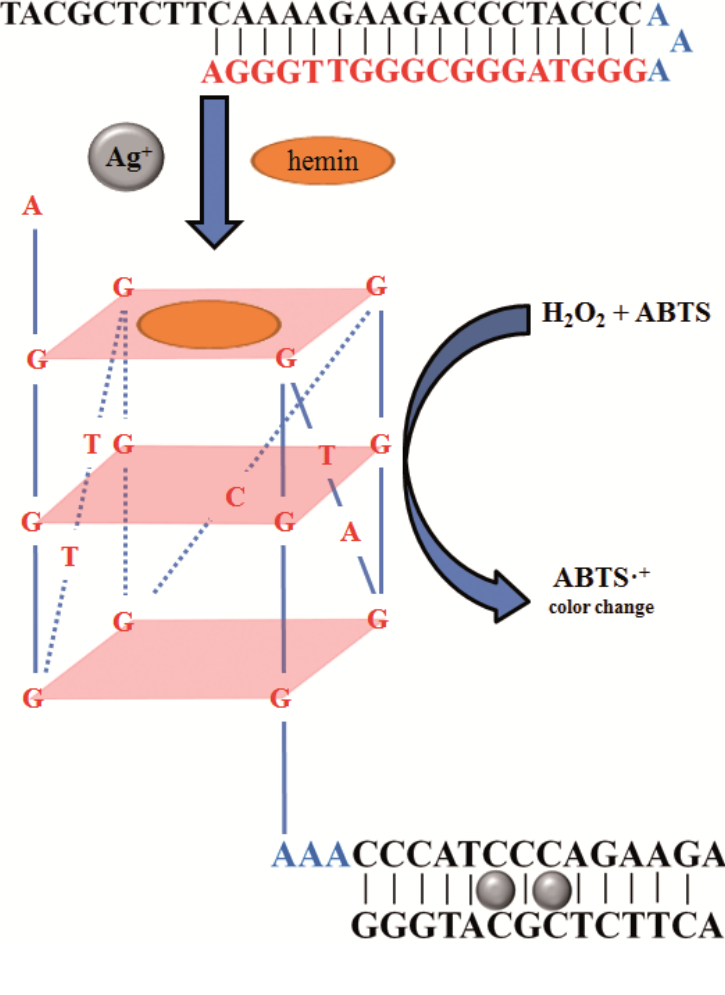
Figure 2. Schematic representation of the G-quadruplex–hemin DNAzyme amplified Ag + -sensing method. Adopted and modified according to Zhou et al.